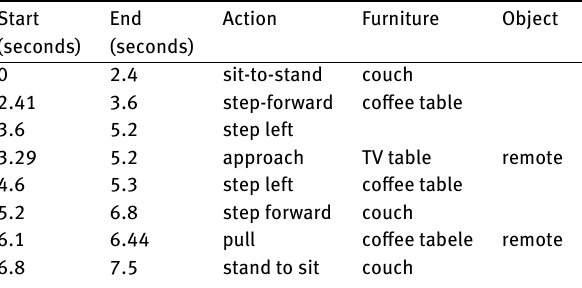
Table 4: The pick the remote scenario: